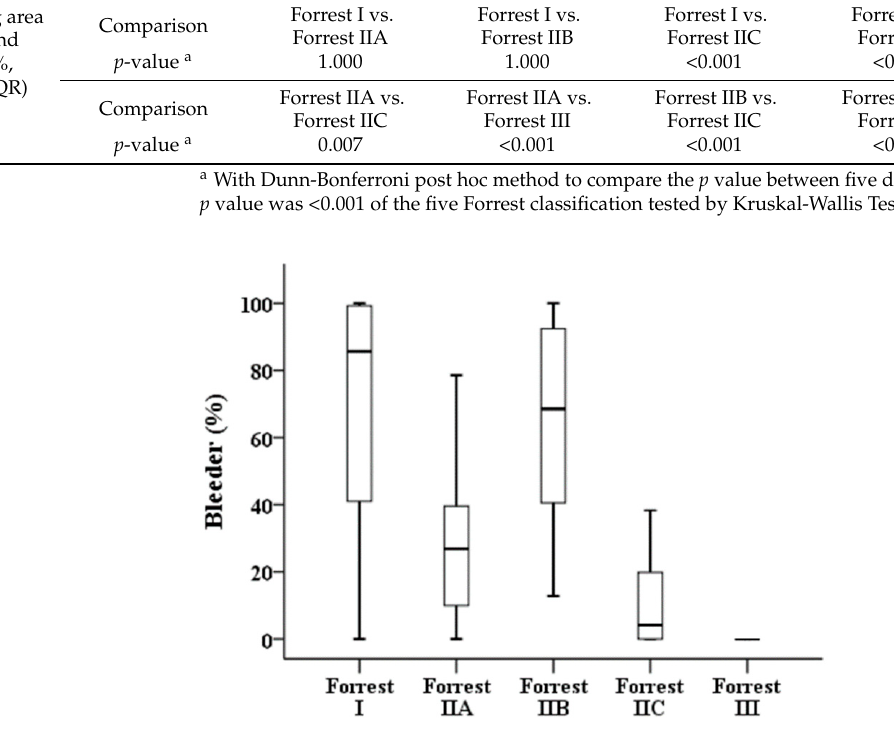
Figure 3. Proportions of bleeding areas in the different stages of the Forrest classification.